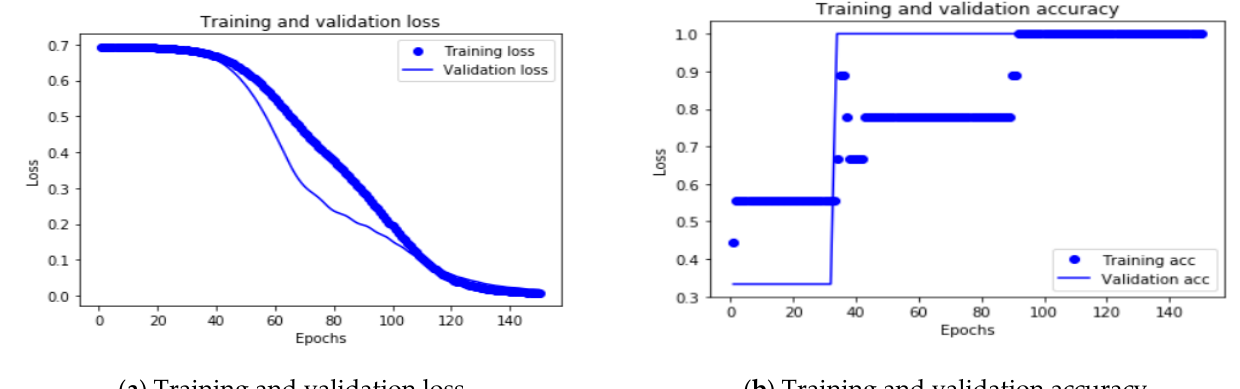
Figure 3. Performance measure during the training phase ( a ) training and validation loss, ( b ) training and validation accuracy.